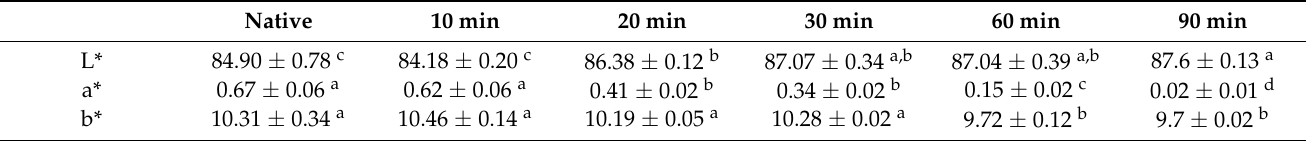
Table 2. Color values of native SBP and its ultrasonic degradation